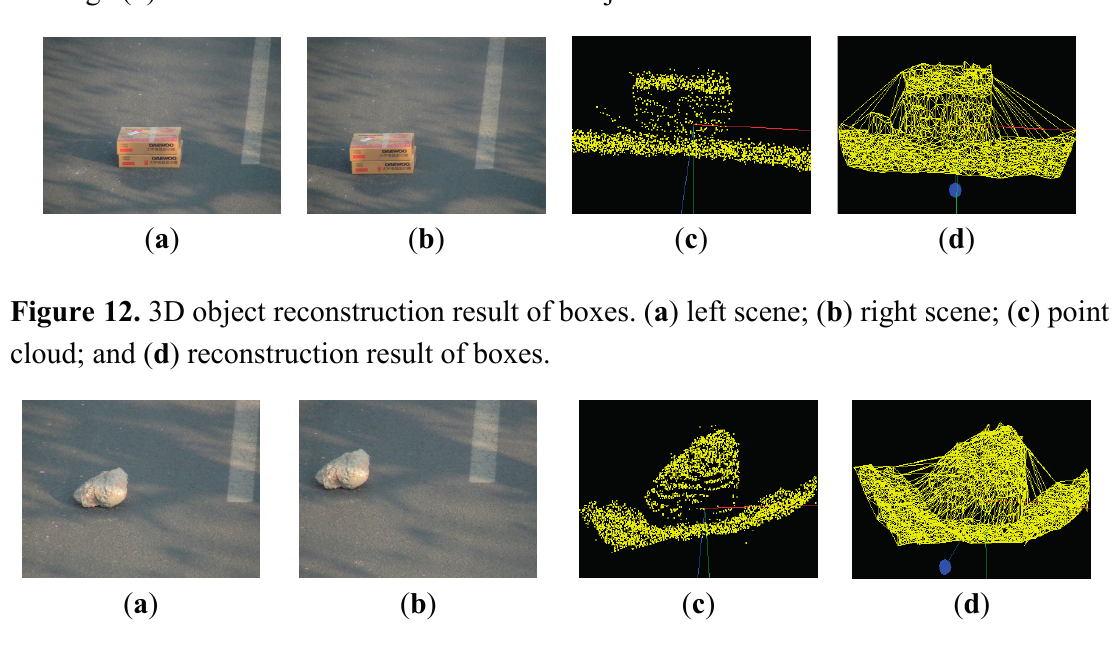
Figure 13. 3D object reconstruction result of stone. ( a ) left scene; ( b ) right scene; ( c ) point cloud; and ( d ) reconstruction result of